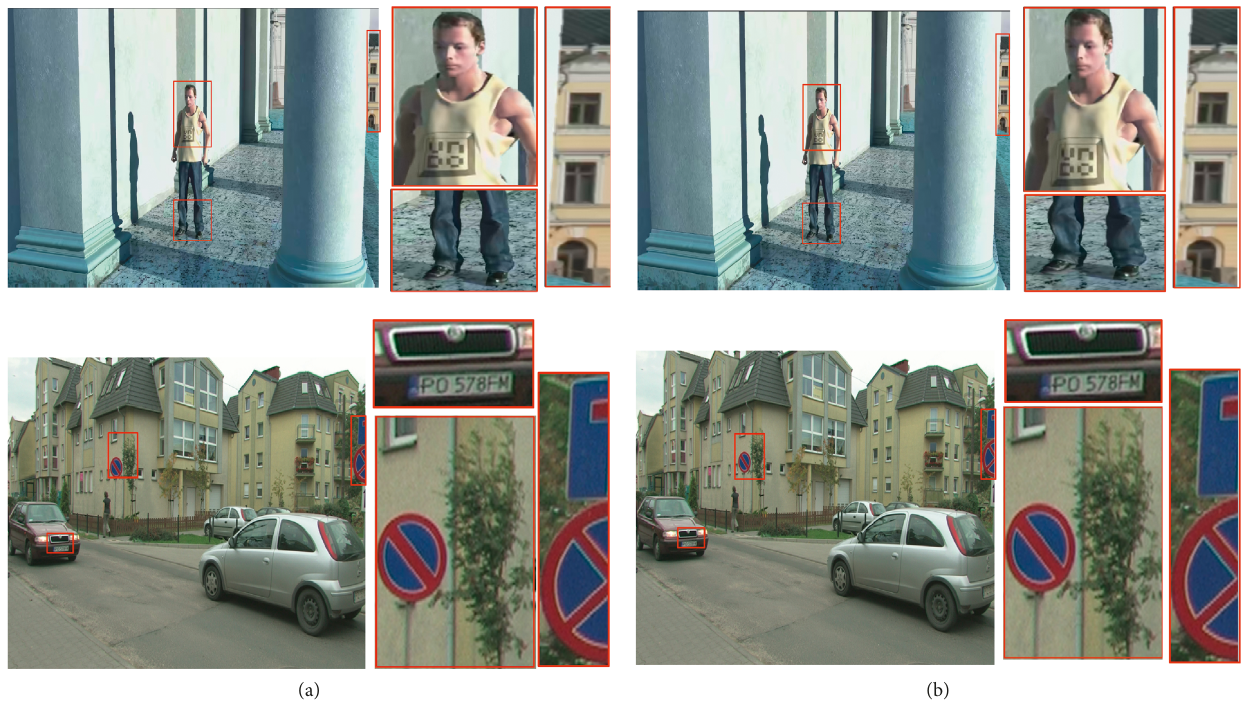
Figure 8: The comparison of the subjective visual quality of the synthesized views of the proposed method (b) and the reference software (a) for UndoDancer and